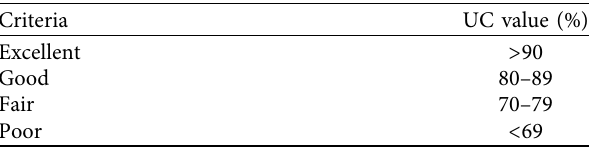
Table 1: Uniformity